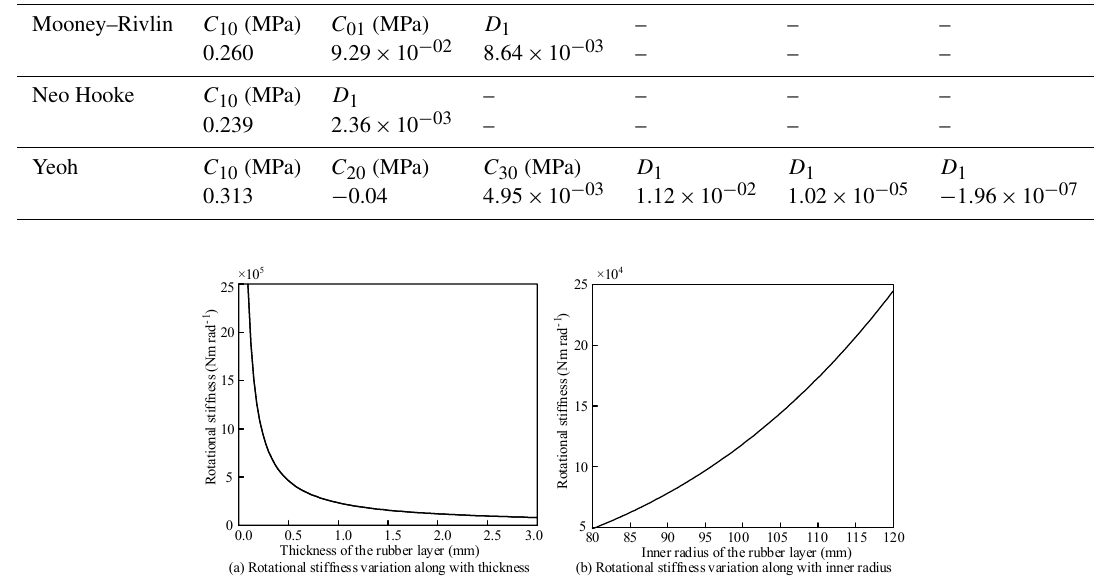
(b) Rotational stiffness variation along with inner radius